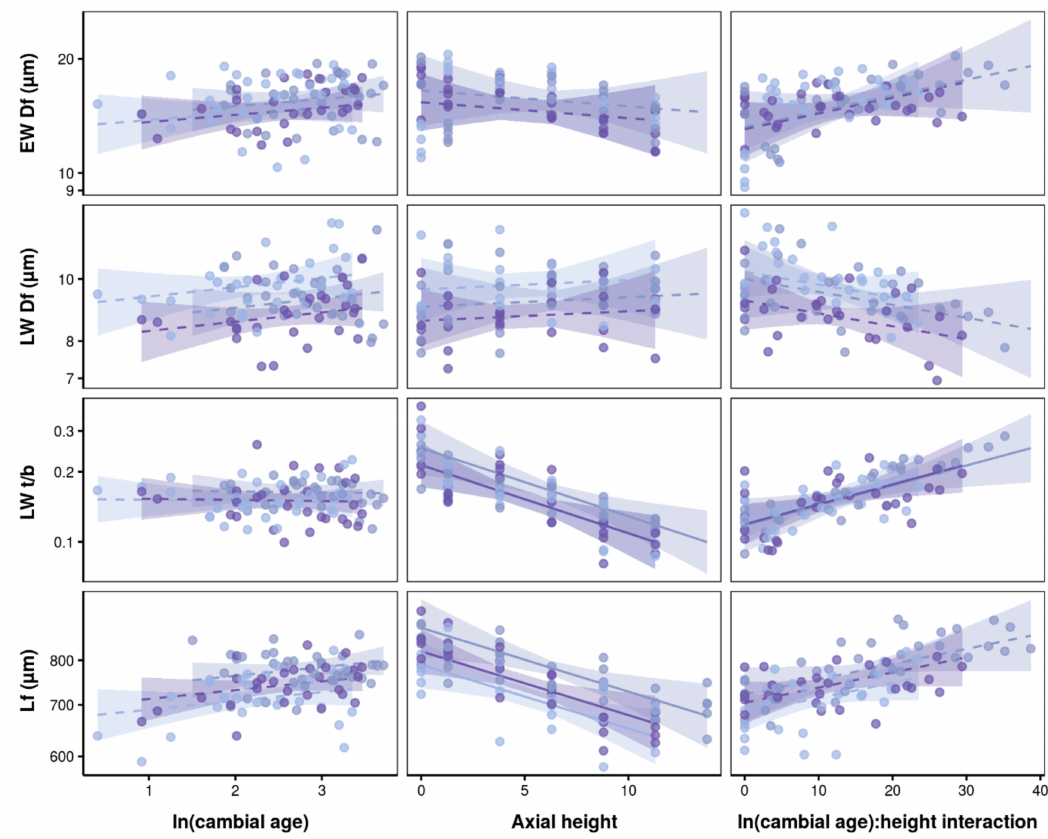
Figure 6. Partial residual plots for the models of fibre traits. The predictions and 95% confidence intervals for each observed value of all three continuous predictors are shown while keeping the other predictors at the average value of the corresponding tree, and partial residuals corresponding to the theoretical values of the response that would be observed when the other predictors were at their average values. Colors represent di ff erent trees; significant relationships are illustrated by solid lines while insignificant relationships are illustrated by dashed